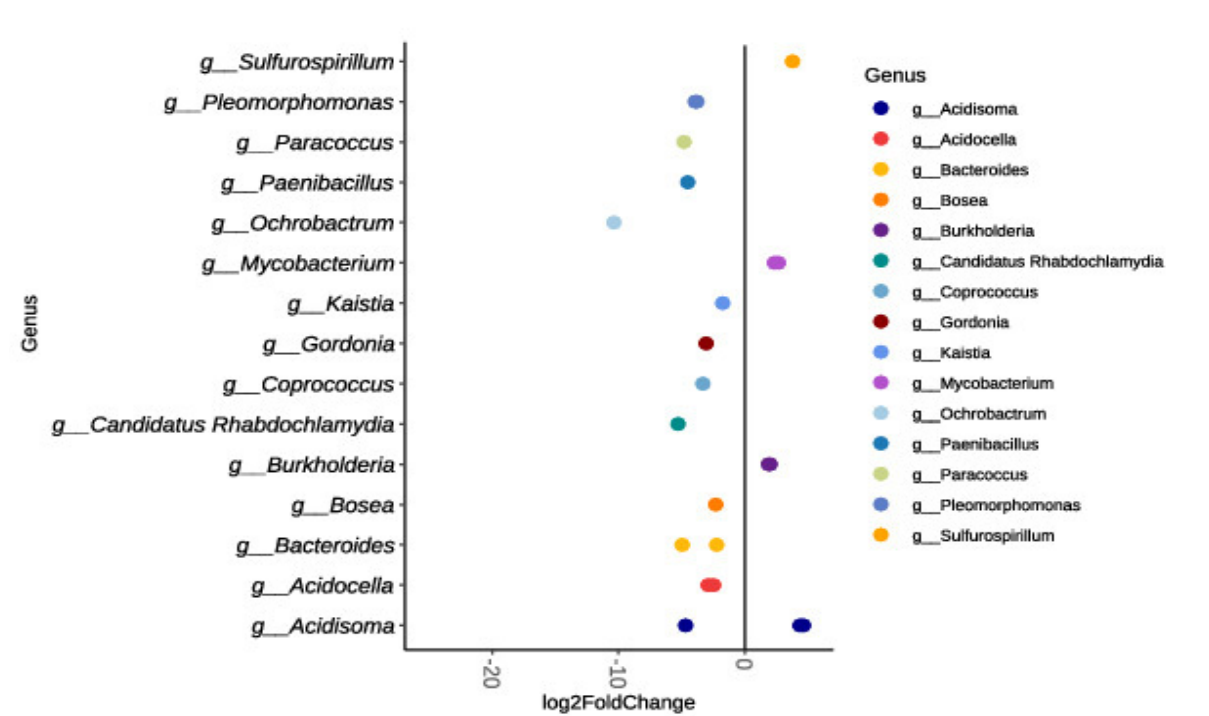
Figure 6. Log2 fold change among the first part (until the middle phase) and the end of the process in average normalized OTU counts grouped at the genus level.